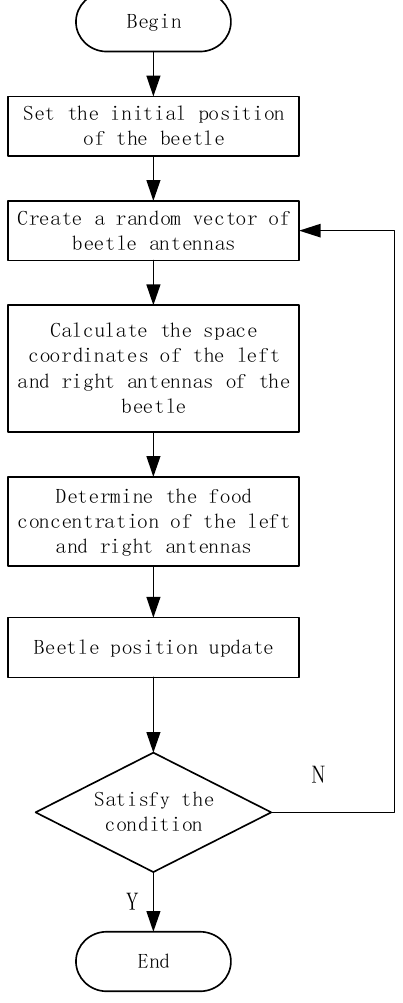
Figure 3. BAS algorithm flow.